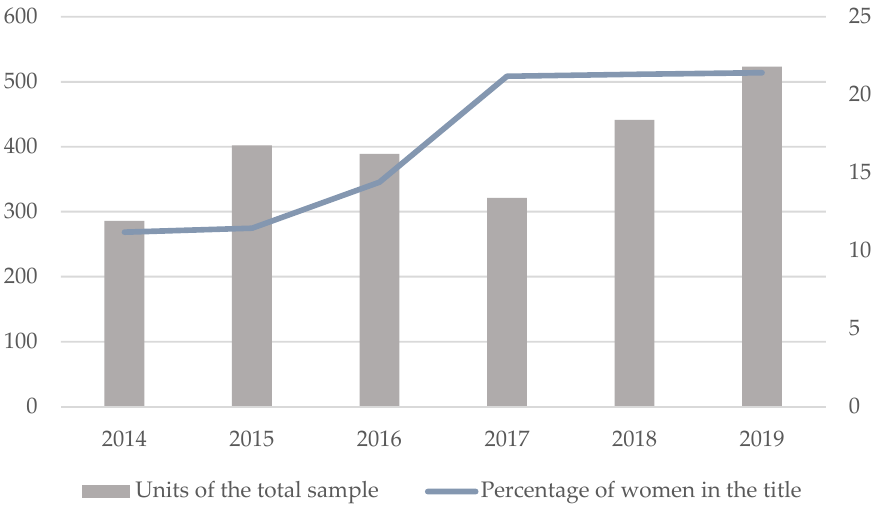
Figure 3. Distribution of the percentage of women in the title, according to the analysis units comprising the sample.